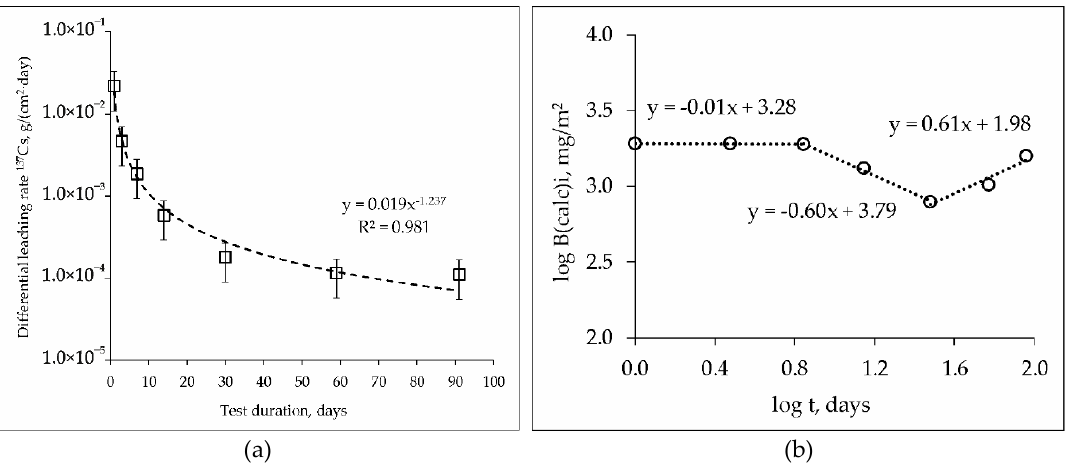
Figure 6. Kinetic curve of the leaching rate ( a ) and logarithmic dependence of the release ( b ) of 137 Cs from the MPPZ compound containing 20 wt% LiCl-KCl-CsCl and 28.6 wt% zeolite.